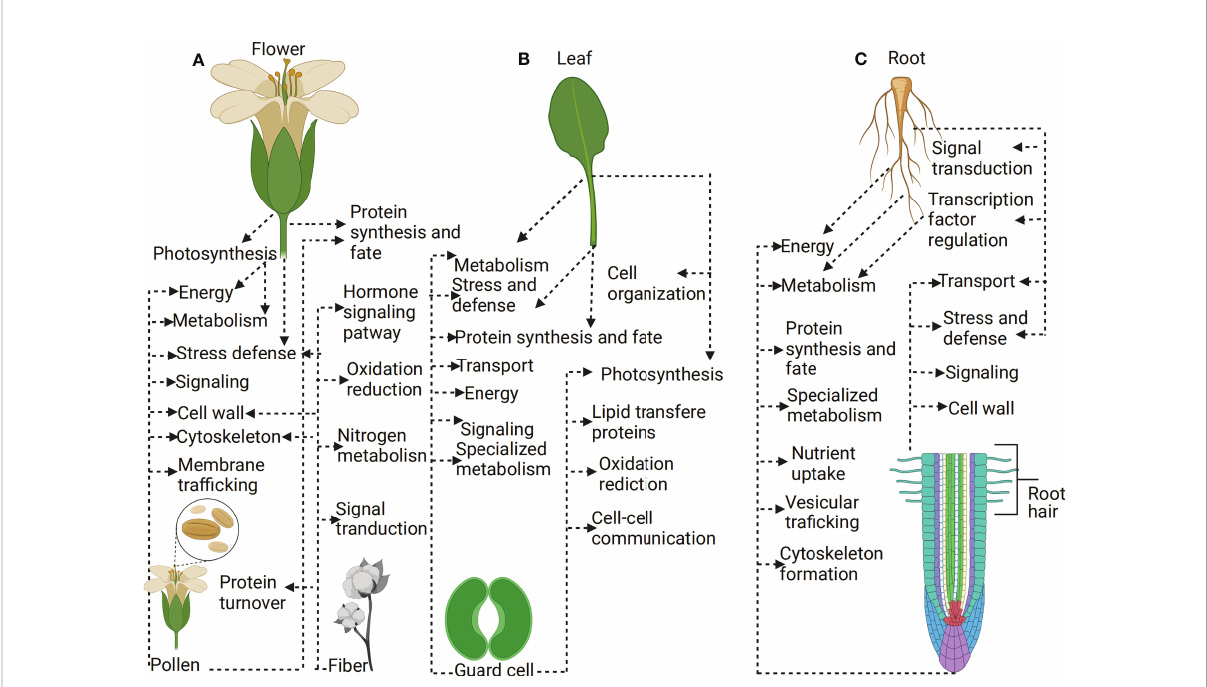
FIGURE 3 Plant single-cell type-proteomics. (A) Proteins expressed in fl ower versus protein expressed in the pollen (B) Proteins expressed in leaf versus protein expressed in the guard cell (C) Proteins expressed in root versus protein expressed in the root hair. Single-cell proteomics allows the identi fi cation of many proteins expressed within thousands of individual cells at a given time. Single-cell-type proteomics treats biological samples as heterogeneous, which reveals the actual function of cells in plant developmental processes or response to stress. The application of single cells proteomics has several advantages, such as providing speci fi c information on cell function than the whole organ or tissue proteomics, which provide average information of